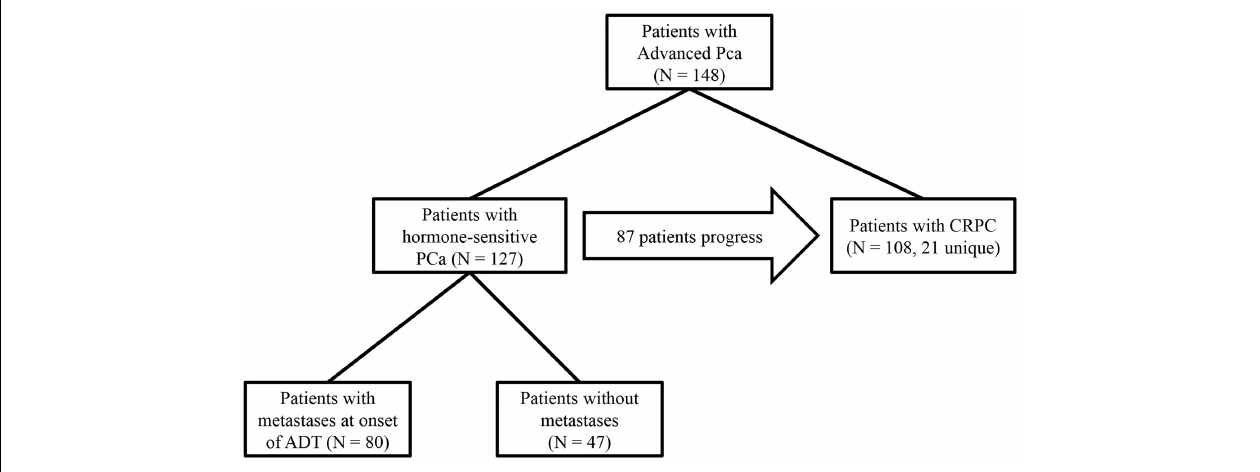
were treated for CRPC whose clinical data from their hormone-sensitive state was not available, totaling 108 patients with CRPC in the study. In all subset of patients, outcomes were compared between patients with diabetes and those without diabetes.